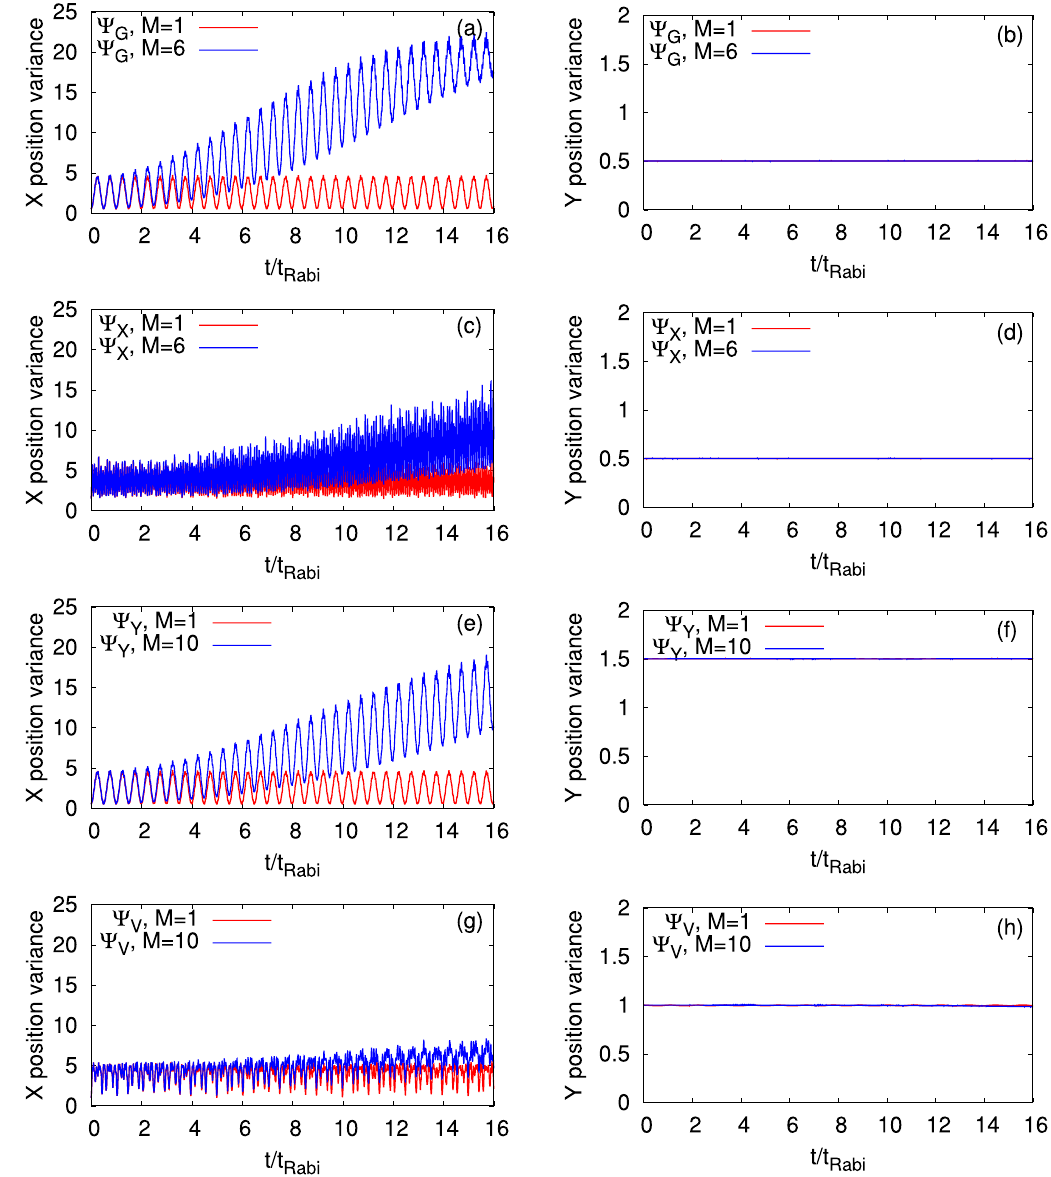
Figure 7. The mean-field ( M position variances per particle, The different initial states, (cid:31) G , (cid:31) X , (cid:31) Y , and (cid:31) V , for N are computed using the MCTDHB method with M (cid:31) V . See the text for more details. The quantities shown are